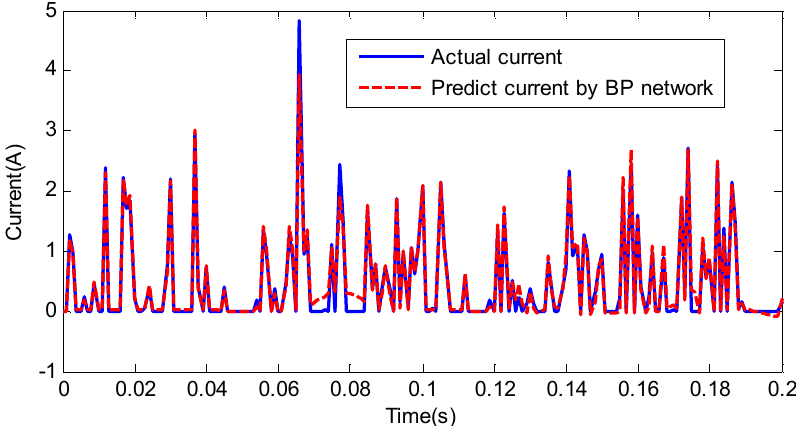
Figure 7. The predicted values of the current using the BP network.